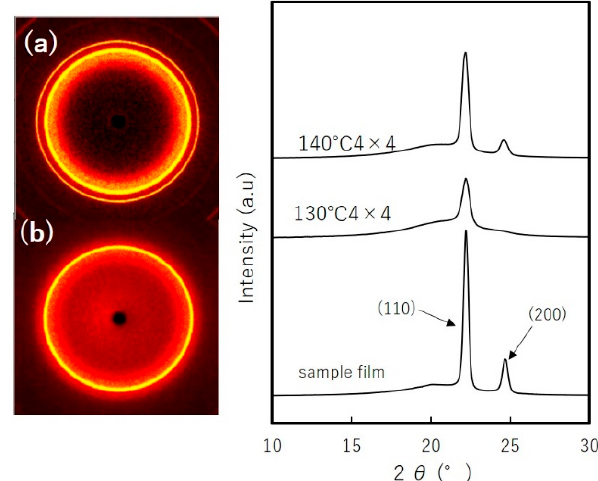
× 4 at: ( a ) 140 ◦ C ( b ) 130 ◦